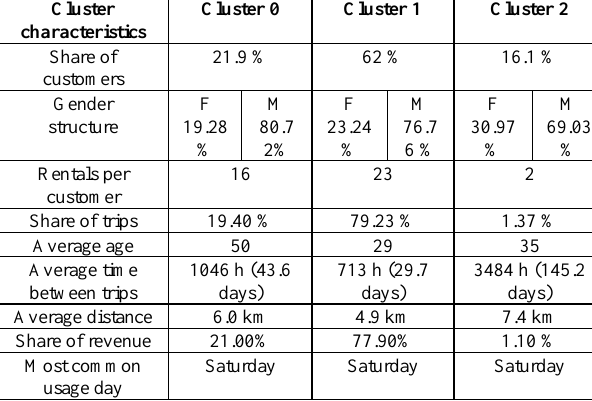
Table 4. Cluster characteristics (F=Female; M=Male)